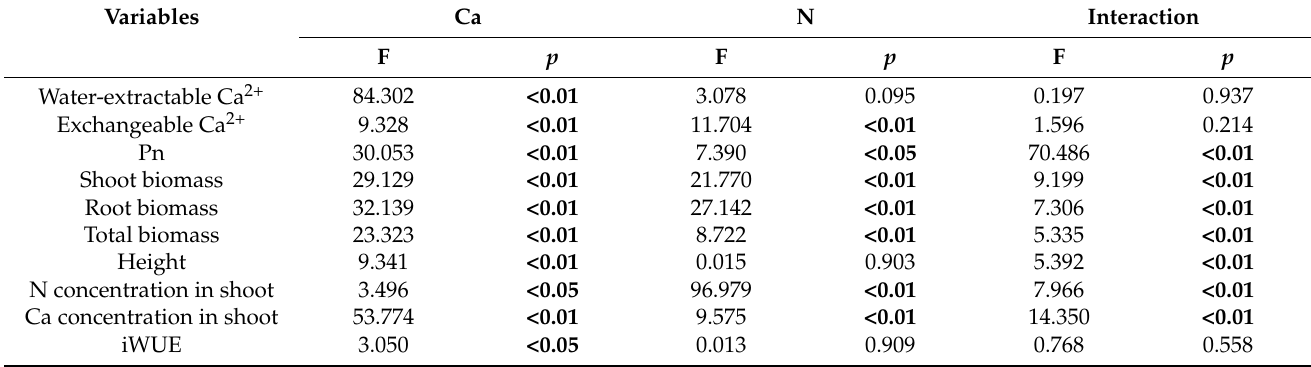
Table 2. Statistical significance of the effects of Ca and N treatments and their interaction on plant and soil parameters as determined using two-way ANOVA. p values < 0.05 are